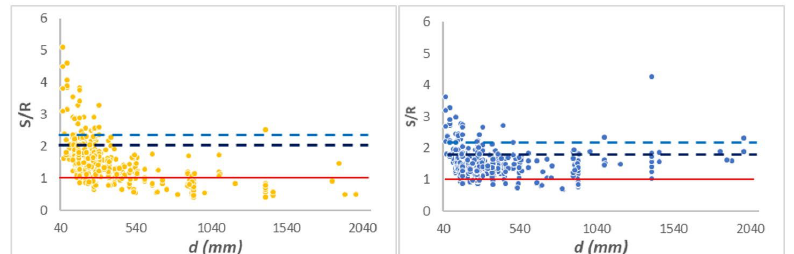
to ACI 318 [3] (yellow) and ACI 318 [3] 𝑑𝑑